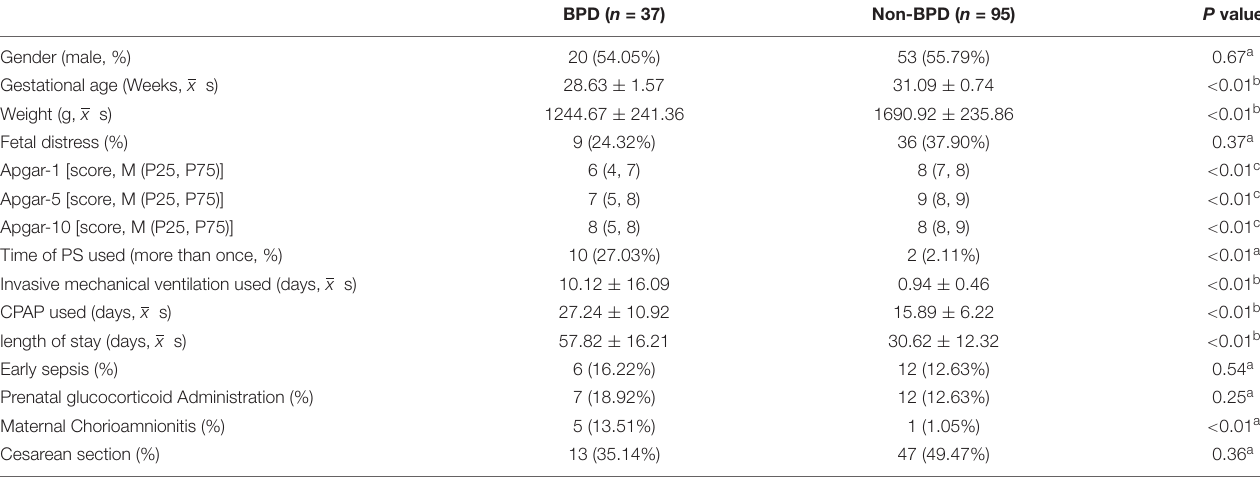
TABLE 1 | Clinical characteristic of BPD